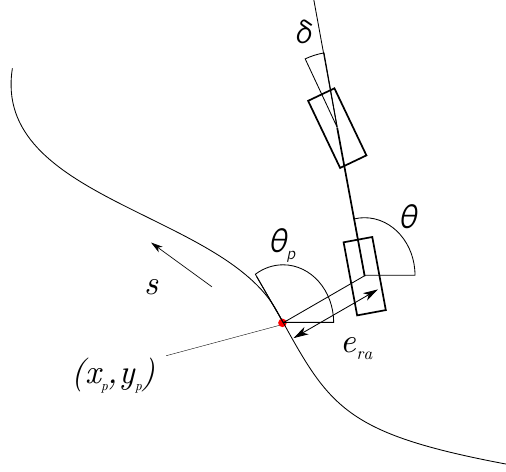
Figure 9. Path representation for kinematic car model as proposed in